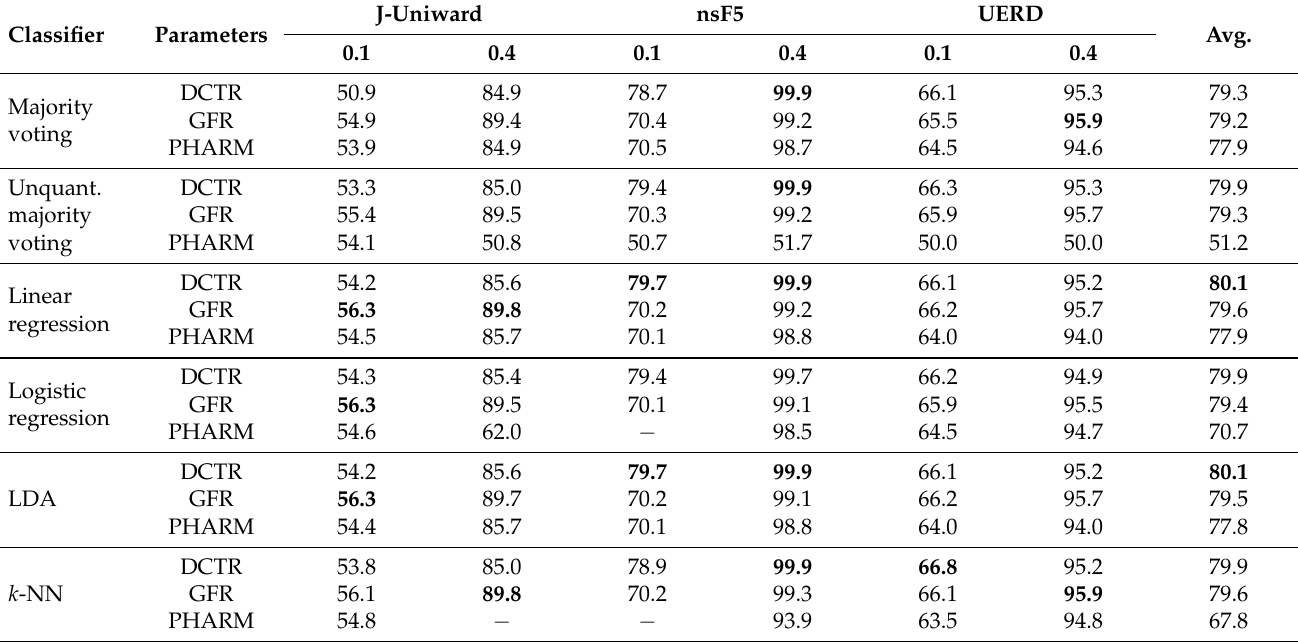
Table 1. Accuracy of image steganography detection (in percentages) for various classifiers and ensemble configurations. The best values in each column are shown in bold.